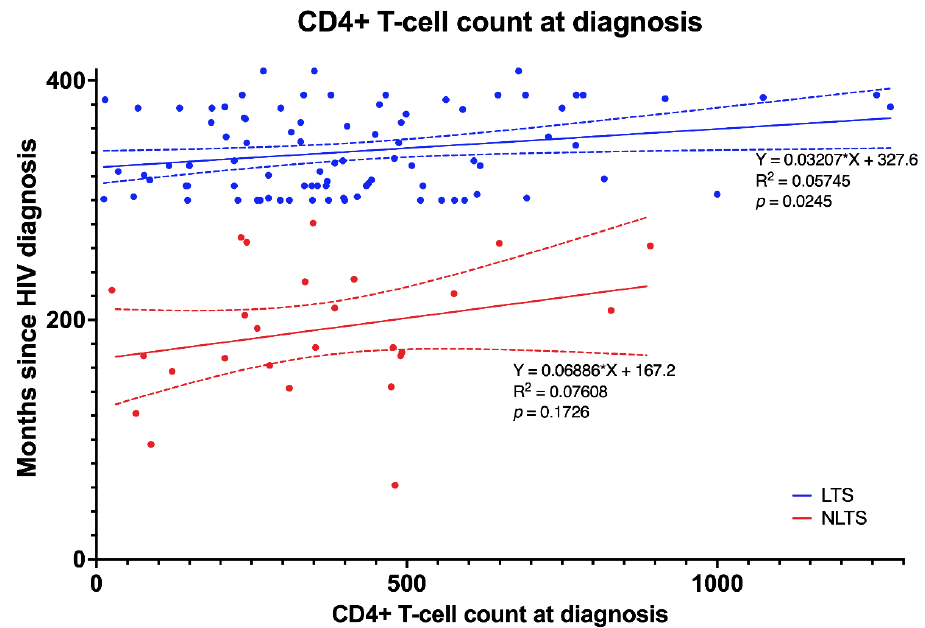
Figure 4. CD4+ T-cell count at diagnosis influences survival time in LTS- but not in NLTS-PLWH on HAART. This figure shows that in LTS-PLWH (blue lines and dots), a statistically significant relationship exists between CD4+ T-cell count at diagnosis and time of survival. Abbreviations: LTS—long-term survivors; NLTS—non-long-term survivors; PLWH—people living with HIV; HAART—highly active antiretroviral therapy. We then studied the differences in terms of CD4+/CD8+ ratio between LTS- and NLTS-PLWH. We did not find any differences between the median CD4+/CD8+ ratio in LTS and NLTS-PLWH ( p = 0.206). The difference was not statistically significant, even when stratifying for a CD4+/CD8+ ratio higher ( p = 0.159) or lower than 0.5 ( p = 0.634) (Figure 5).